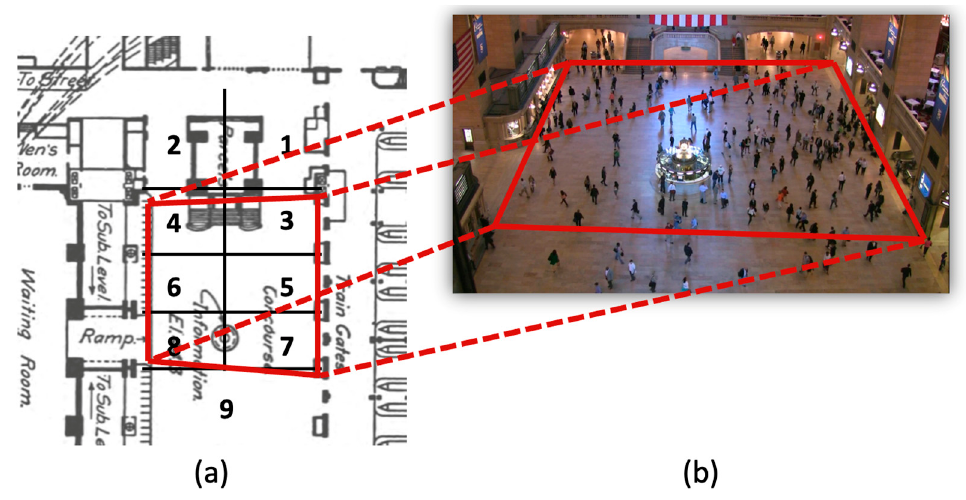
Figure 2. Illustration of the spatial alignment and egress region identification process. ( a ) The location of the egress regions overlaid on the Grand Central Station floorplan, adopted from [19]. ( b ) The video frame needs to be aligned spatially.